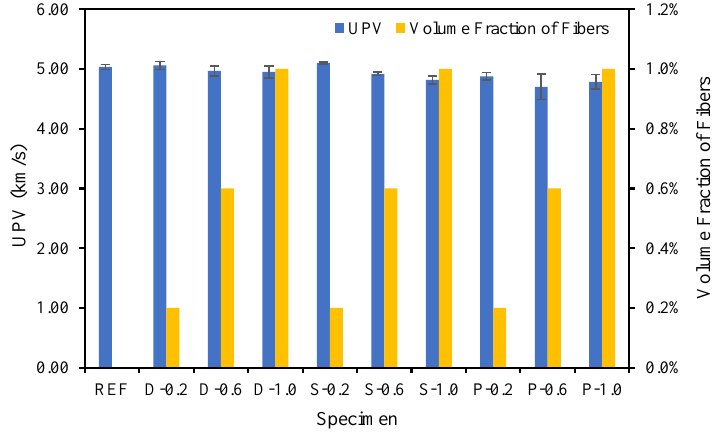
Figure 12. Different fiber influences on the UPV of fibrous concrete samples.